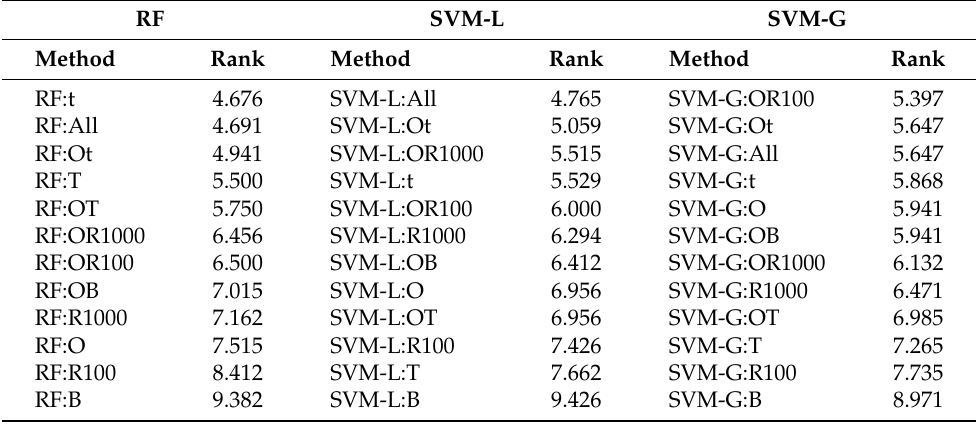
Table 6. Average ranks for each classification